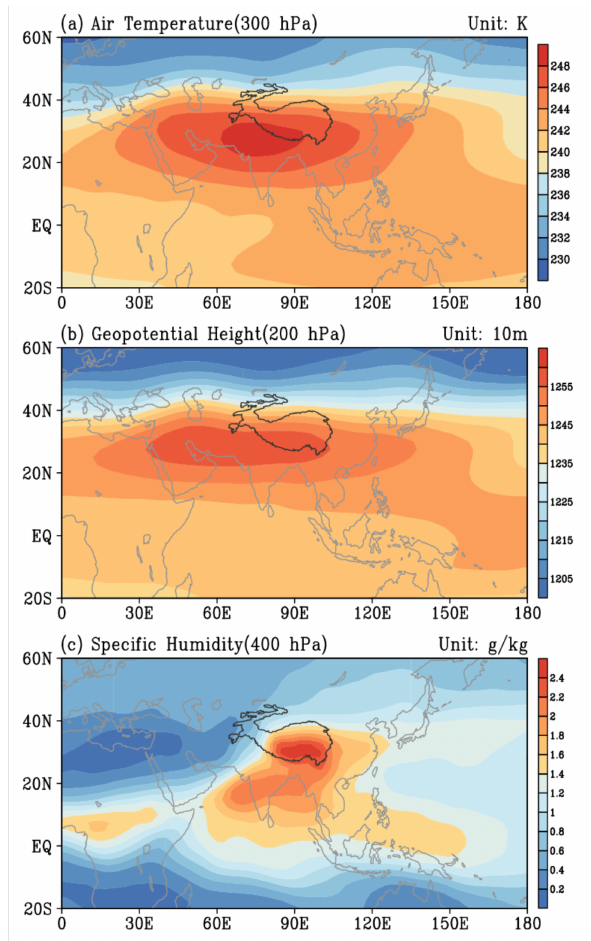
Figure 1. Climatological mean July ( a ) air temperature (K) at 300 hPa, ( b ) geopotential height (10 m) at 200 hPa and ( c ) specific humidity (g/kg) at 400 hPa for the period 1979–2022. The thick-black contour denotes the elevation of 2000 m. The analysis is based on the NCEP-NCAR reanalysis data [12] (https://psl.noaa.gov/data/ (accessed on 24 January